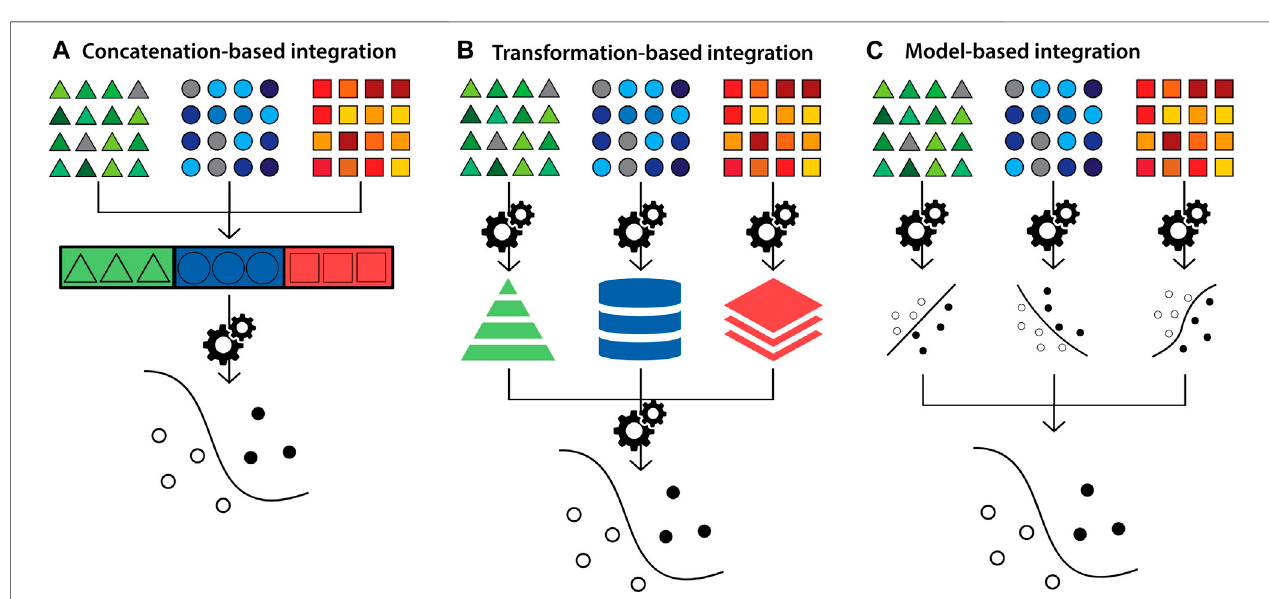
FIGURE3| Diagramdepictingmulti-modaldataintegrationstrategiesaccordingtotheconcatenation-,transformation-andmodel-basedcategorisation.Triangles (green),circles (blue) and squares(orange) represent datasets from distinctbiological data modalities. (A) In concatenation-based integration, multi-modal datais joined at the raw or processed level before being passed to an ensuing model for analysis. (B) In transformation-based strategies, each data modality undergoes modelling to transform features separately, which are subsequently integrated and passed to a fi nal model for analysis (C) In model-based integration, each data modality undergoes modelling and analysis independently, and model outputs are integrated to generate the fi nal